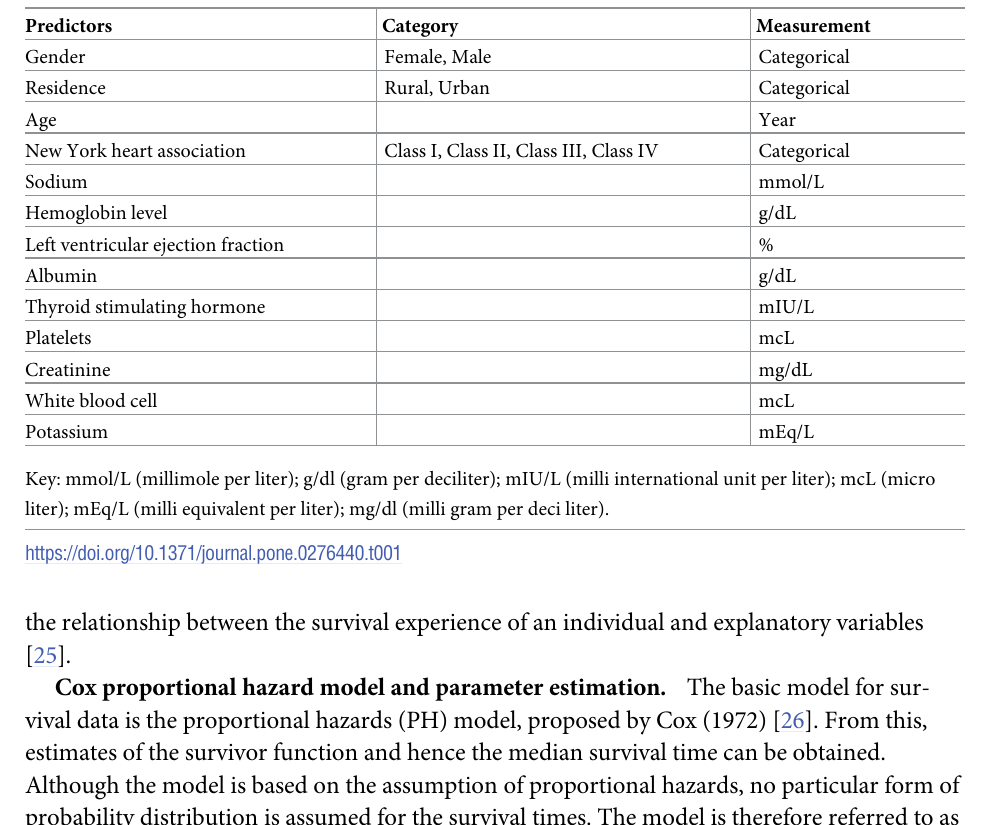
Table 1. Predictor variables considered in the